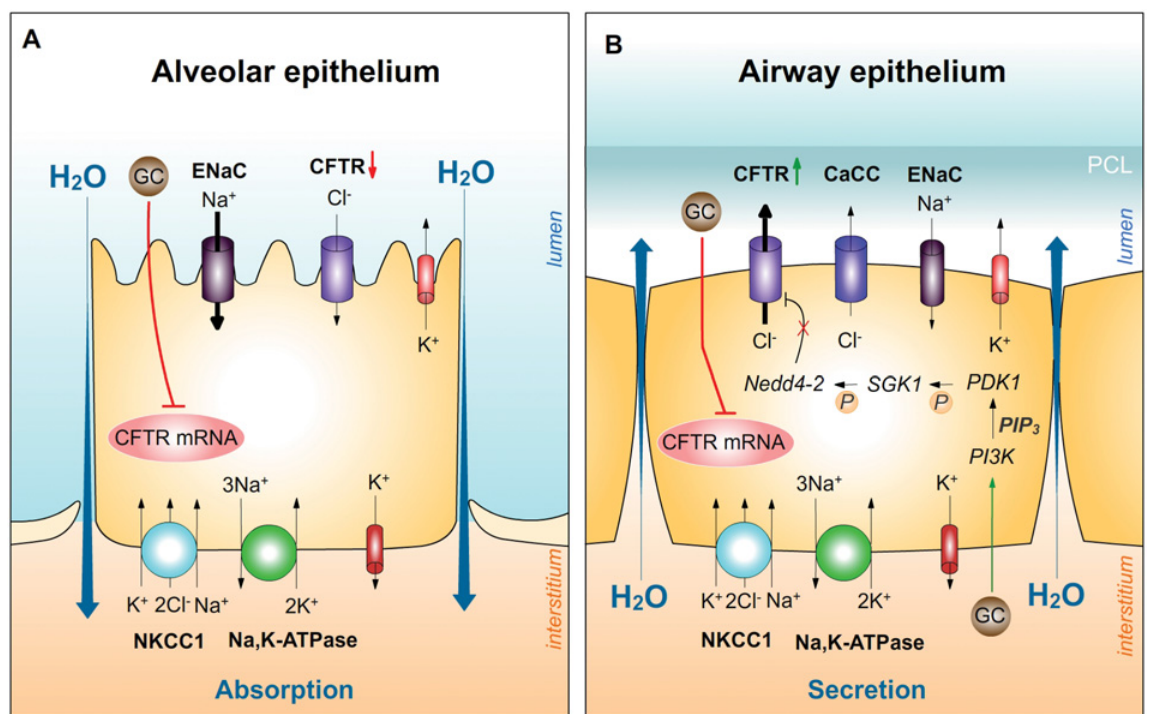
Fig 11. Effect of GCs on CFTR expression and activity in alveolar and airway epithelial cells. A: Postnatal alveolar cells predominantly exhibit Na + absorption. Na + enters the alveolar cells through apical Na + channels like ENaC and is actively extruded basolaterally by the Na,K-ATPase. Thereby an osmotic gradient is generated that drives fluid absorption from the alveolar lumen into the interstitium. Apical CFTR is suggested to mainly absorb Cl - in postnatal alveolar cells. GCs were shown to markedly reduce CFTR mRNA expression and activity in alveolar cells. B: In airway epithelial cells, Cl - enters the basolateral membrane across NKCC1 and Na + is actively extruded by the Na,K-ATPase. K + channels recycle K + at the basolateral side hyperpolarizing the membrane which represents the driving force for apical Cl - extrusion through CFTR and Ca 2+ -dependent Cl - channels (CaCC). Vectorial Cl - transport drives water secretion into the airways. GCs reduced CFTR mRNA expression, but increased CFTR activity which supposedly depends on the proposed kinase pathway. GCs activate the PI3K leading to the generation of phosphatidylinositol (3,4,5)-trisphosphate (PIP 3 ). Phosphoinositide-dependent kinase-1 (PDK1) is activated and further phosphorylates and activates SGK1. SGK1 in turn interacts with the ubiquitin-ligase Nedd4-2 reducing the affinity of Nedd4-2 for CFTR. Thereby the endocytic retrieval of CFTR is inhibited and CFTR plasma membrane abundance increased. PCL = periciliary liquid layer. Not all potentially important ion transporters and kinases are included in this schematic